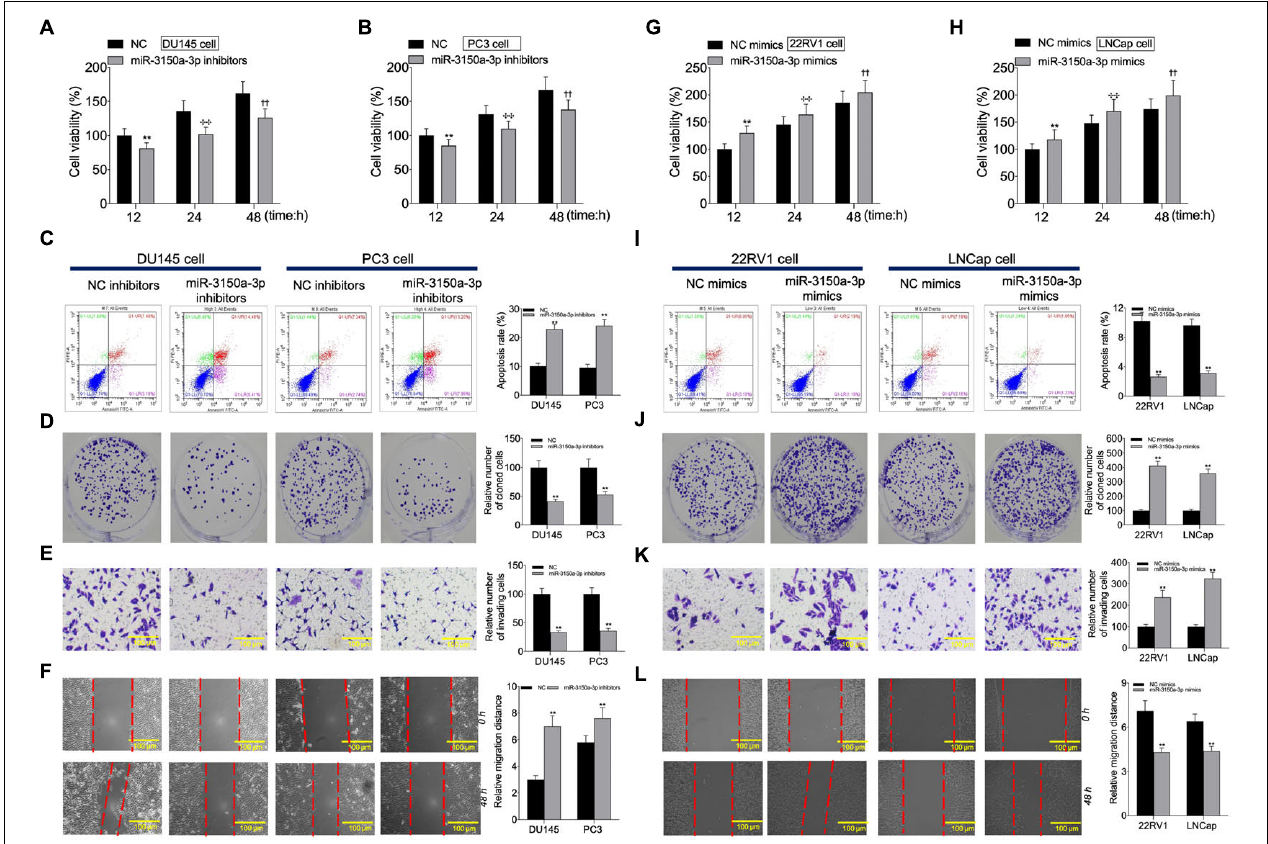
FIGURE 6 | miR-3150a-3p regulated cell proliferation, apoptosis, migration, and invasion in vitro. Cell viability (A,B,G,H) , cell apoptosis (C,I) , proliferation (D,J) , invasion (E,K) , and migration (F,L) of cells transfected with miR-3150a-3p inhibitors or miR-3150a-3p mimics determined by CCK-8, flow cytometry, colony formation, Transwell, and scratch assays. The experiment was repeated thrice independently; ** vs. NC inhibitors or NC mimics group, p < 0.01; (cid:67)(cid:67) vs. vector at 24 h group; †† vs. vector at 48 h